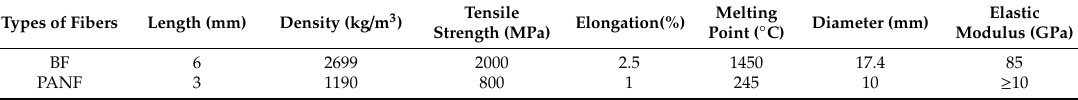
Figure 1. Chopped fiber features: ( a ) polyacrylonitrile fiber (PANF); ( b ) basalt fiber (BF). Table 3. The fundamental properties of basalt fiber and polyacrylonitrile fiber.